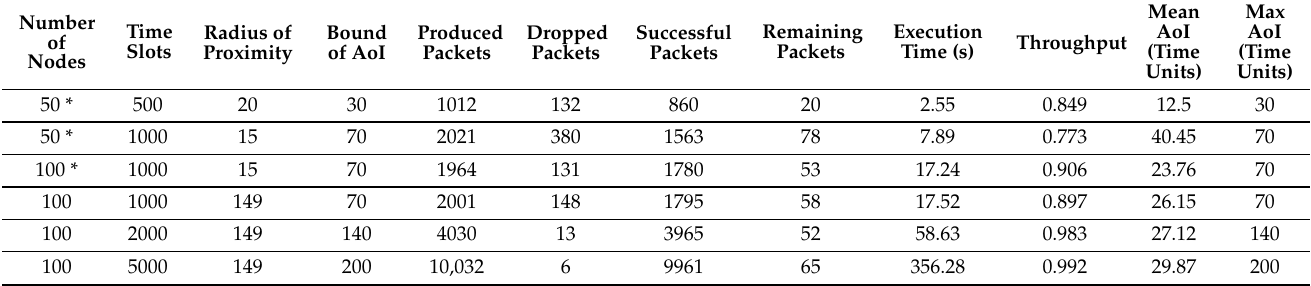
Table 2. Initial results for Modified-neigh.